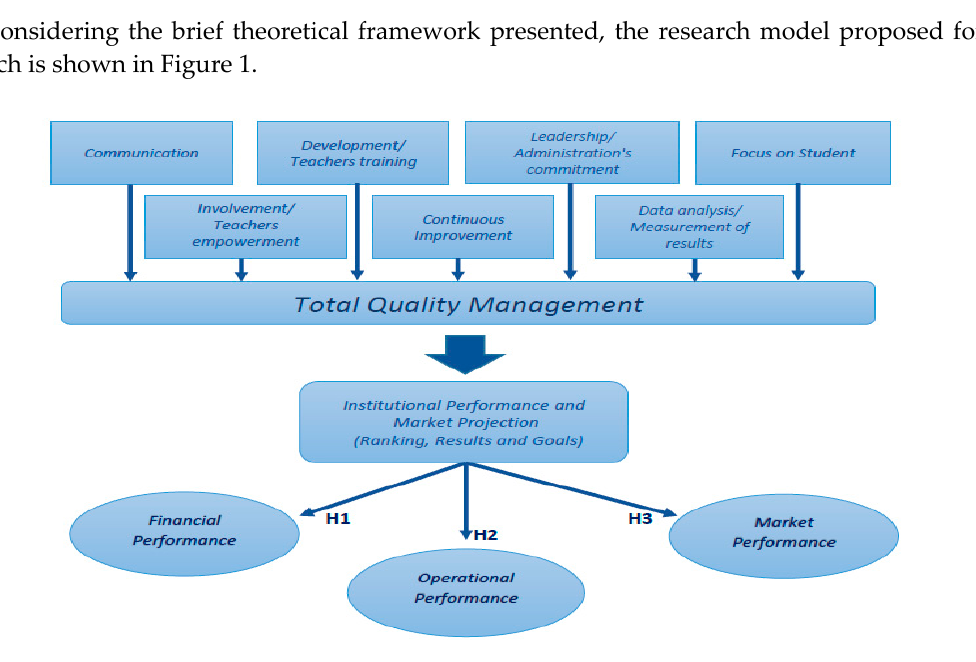
Figure 1. Conceptual model and research